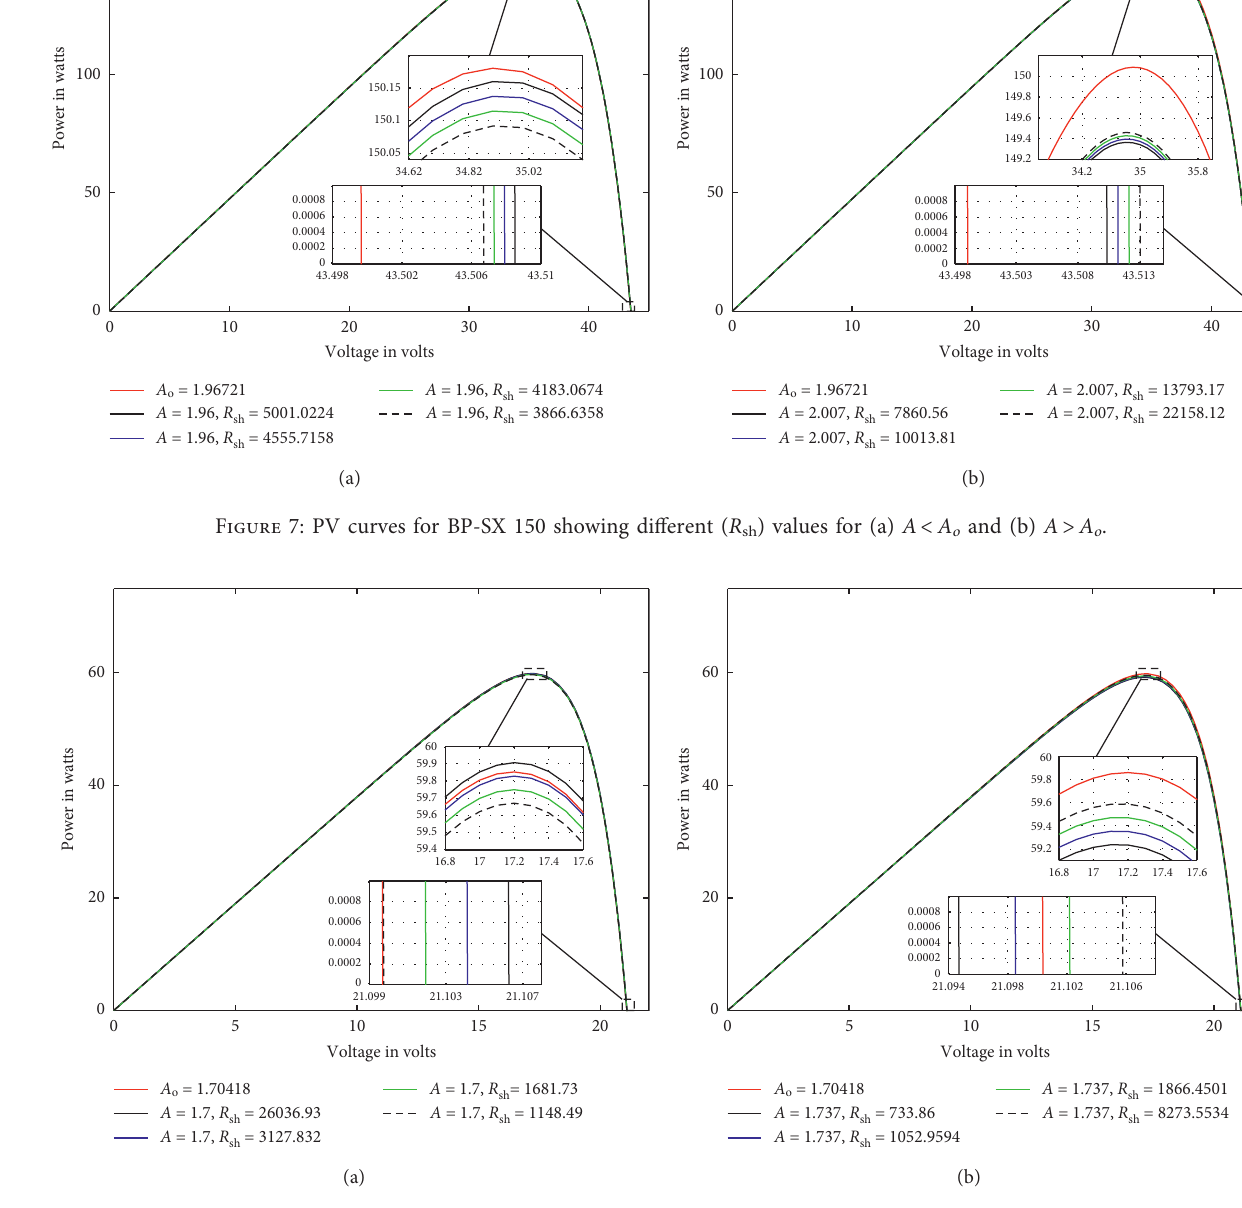
sh ) values for (a) A < A o and (b) A > A o